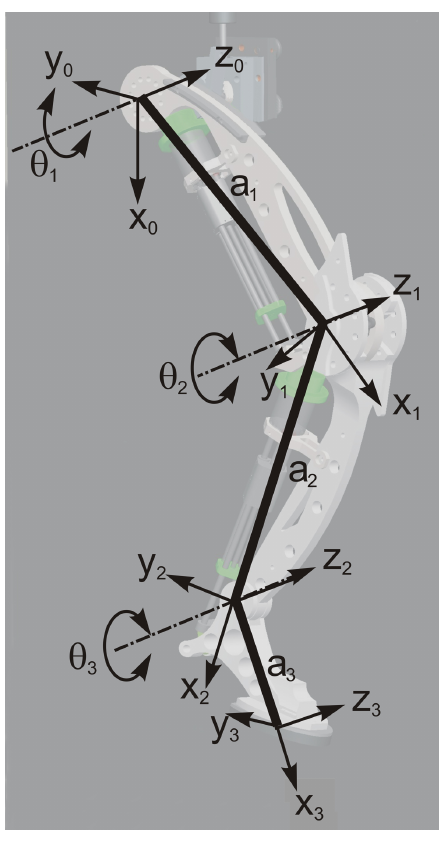
Figure 3. Kinematic model of robot